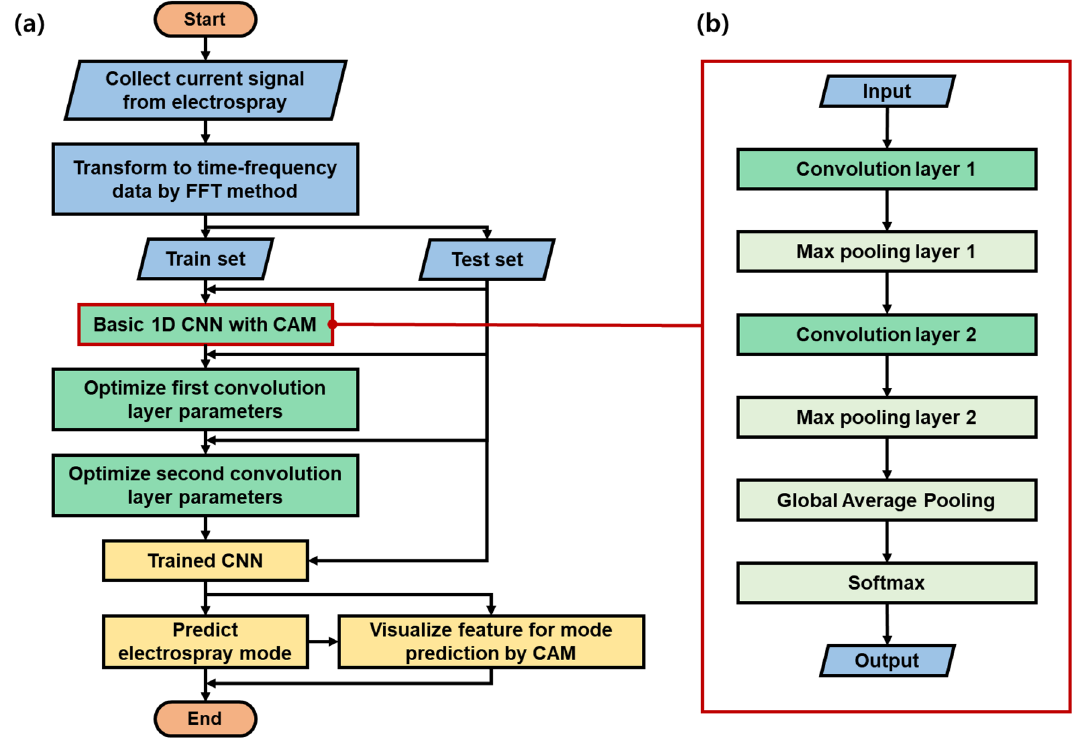
Figure 3. ( a ) Preparation of 1D CNN with CAM for electrospray mode prediction. ( b ) Detailed structure of 1D CNN with